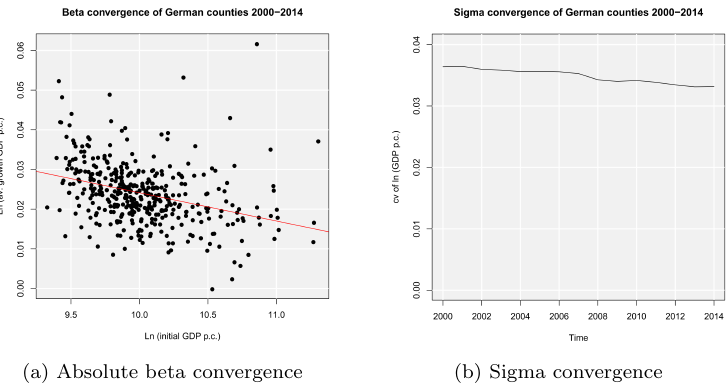
Figure 2: Regional convergence in Germany 2000-2014 (n = 402